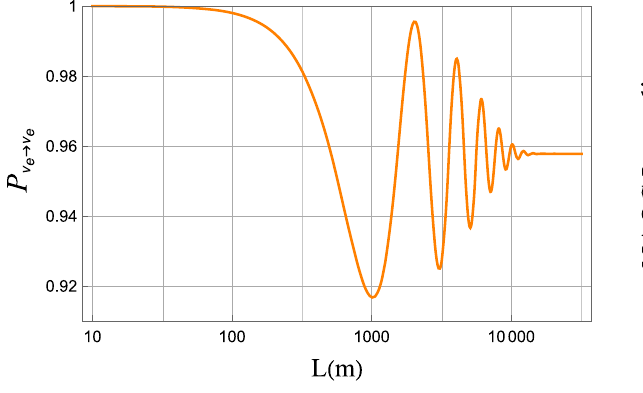
Fig. 2 On the left panel is shown the survival transition for an electronic neutrino in the wave packet approach. The plot is done with the following values of parameters: E = 2 MeV, ξ = 0, sin 2 2 θ 13 = 0 . 084 ± 0 . 005 and Δ m 2 ee = 2 . 42 + 0 . 10 −